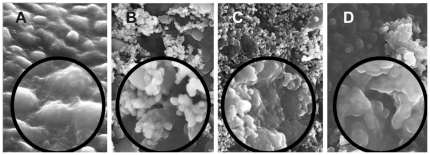
Toxicity characteristics of Zebrafish embryos and larvae.The normal developing embryos and larvae exposed in the reconstituted water (A), 400 mg/L nano-TiO2 (B), 400 mg/L nano-SiO2 (C) and 400 mg/L nano-HA (D). AM- axial malformation, E- edema, P- pericardial, PE- pericardial edema, YS- yolk sac and YSE- yolk sac edema.